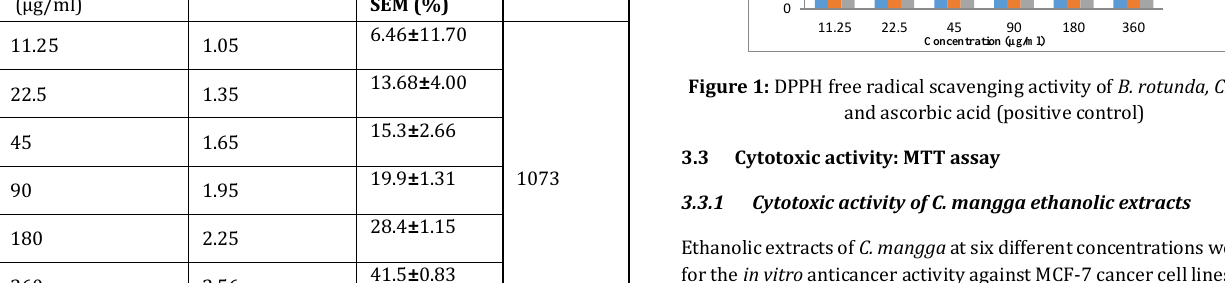
Table 1: C. mangga ethanolic extract DPPH test Concentration of C.mangga extract